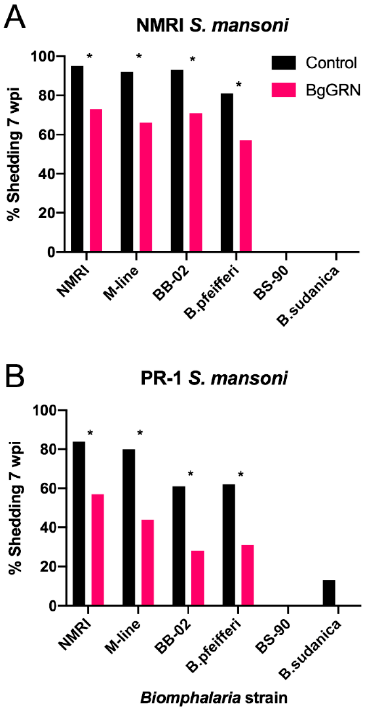
Figure 4. Infection prevalence seen across multiple strains of B. glabrata , as well as B. pfeifferi and B. sudanica in both control groups and groups having been injected with full-length BgGRN ( n = 46 per treatment for each species/strain). Snails were infected with either ( A ) NMRI S. mansoni or ( B ) PR-1 S. mansoni . Significant differences ( p < 0.05) between control and BgGRN treated groups as determined via a Chi-squared test are denoted using an asterisk.